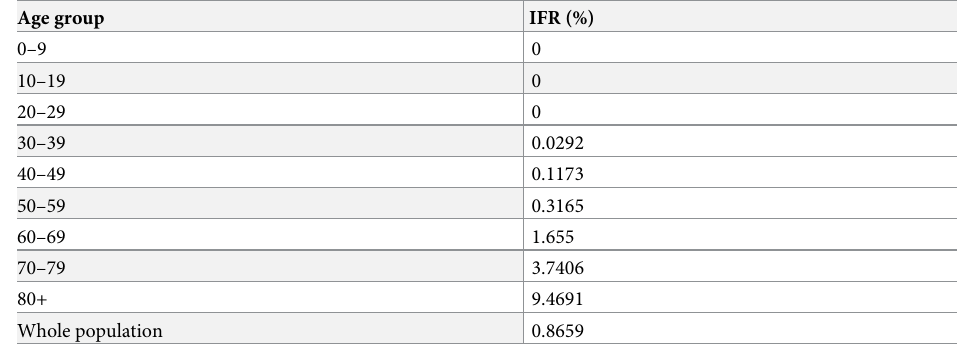
Table 1. Age-stratified infection fatality ratio (IFR) from a single simulation of